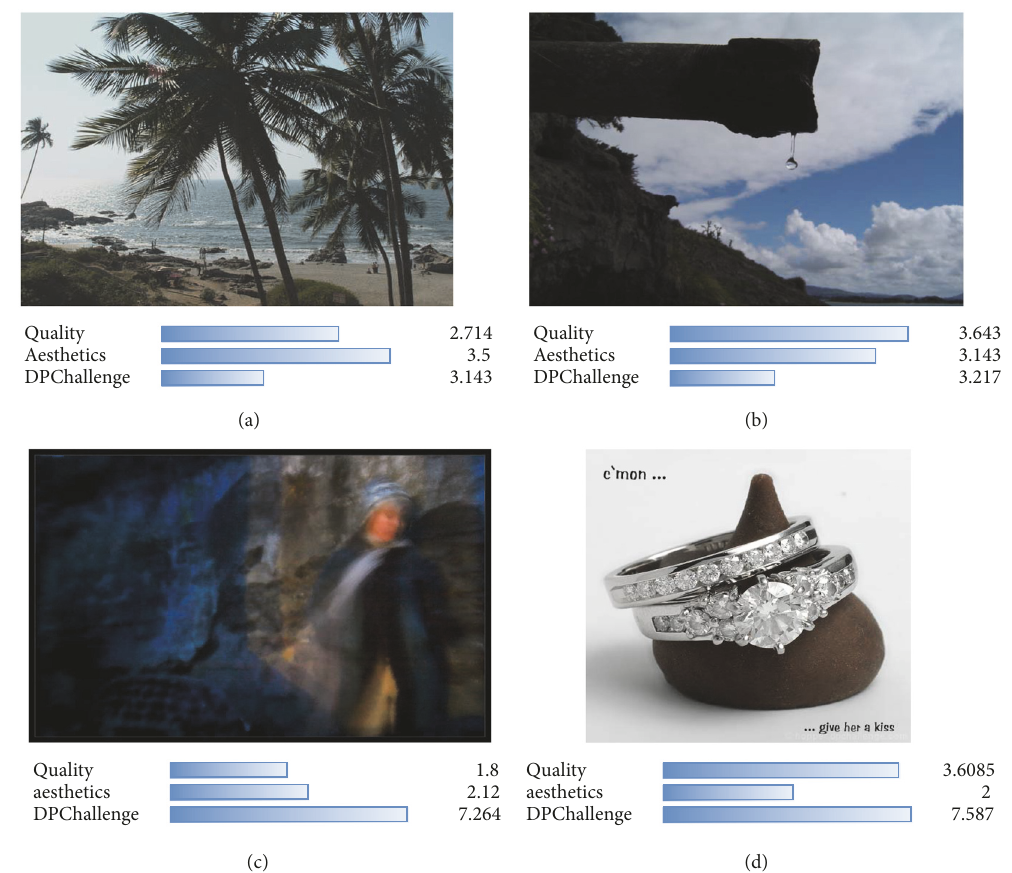
Figure 8: Examples of images with different scores based on the three evaluation criteria. For each image, a number value is given according to each criterion, while bars show the normalised weight of such value within each assessment range (DPChallenge in the [1, 10] range and aesthetics and quality in the [1,5]